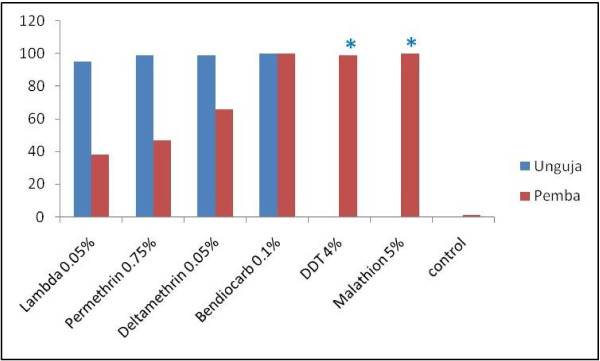
Mosquito response (24 hr mortality) to different insecticides on Unguja and Pemba. The results from Pemba are a summary of three testing periods. *DDT and Malathion were not tested on Unguja due to lack of sufficient samples.